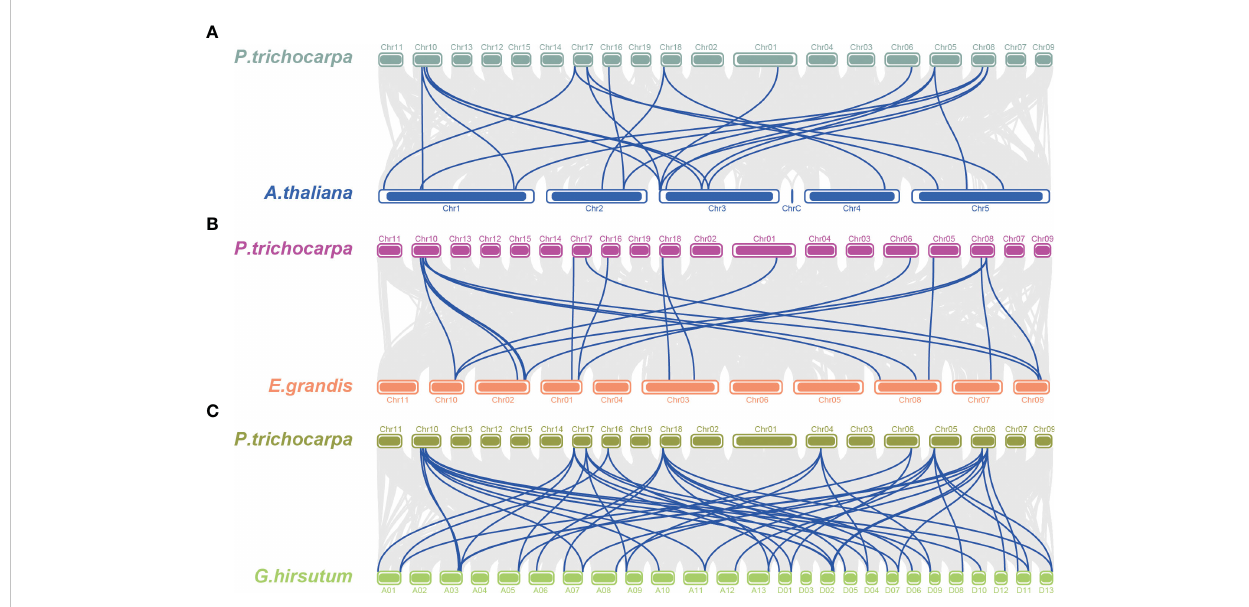
FIGURE 6 Collinearity analysis between different genomes. (A) Collinear analysis of Populus trichocarpa and Arabidopsis thaliana . (B) Collinear analysis of Populus trichocarpa and Eucalyptus grandis . (C) Collinear analysis of Populus trichocarpa and Gossypium hirsutum . Grey lines indicate the collinear blocks within Populus trichocarpa and different genomes, the blue line indicates collinear gene pairs.